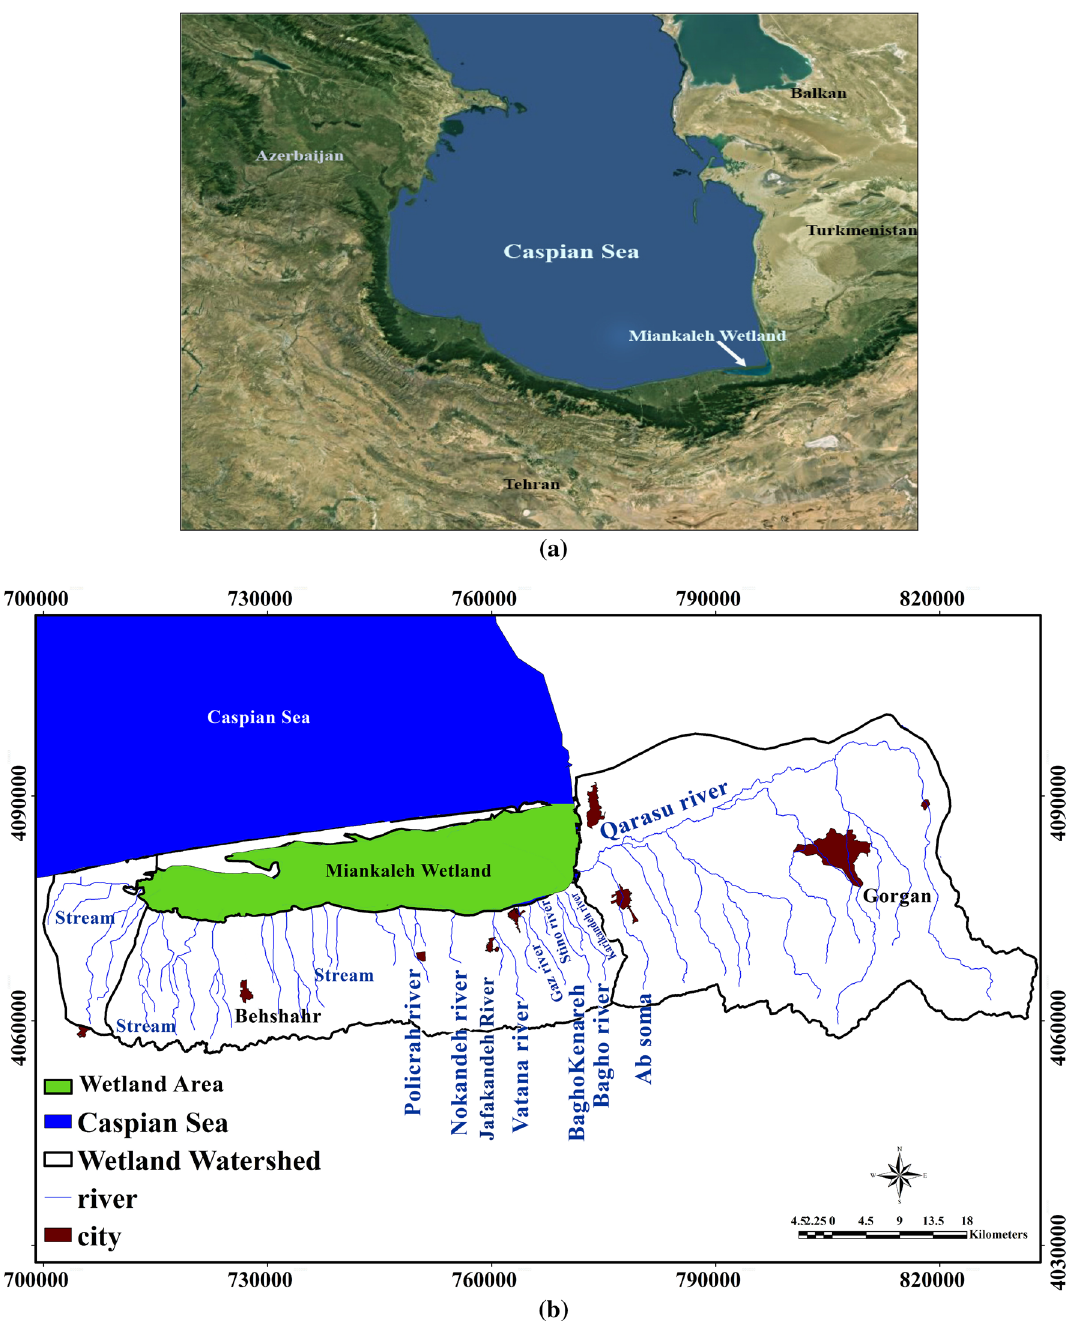
Fig.1 a Location of the Miankaleh wetland, b the rivers of the wetland ̉s